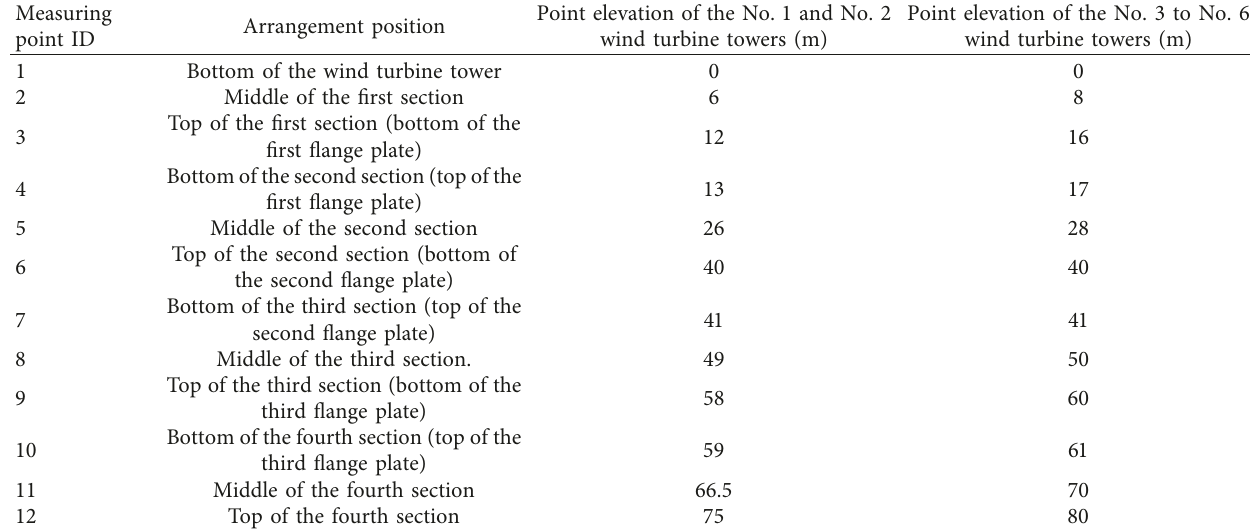
Table 2: Description of the horizontal vibration measuring points in the prevailing wind direction of each wind turbine tower.